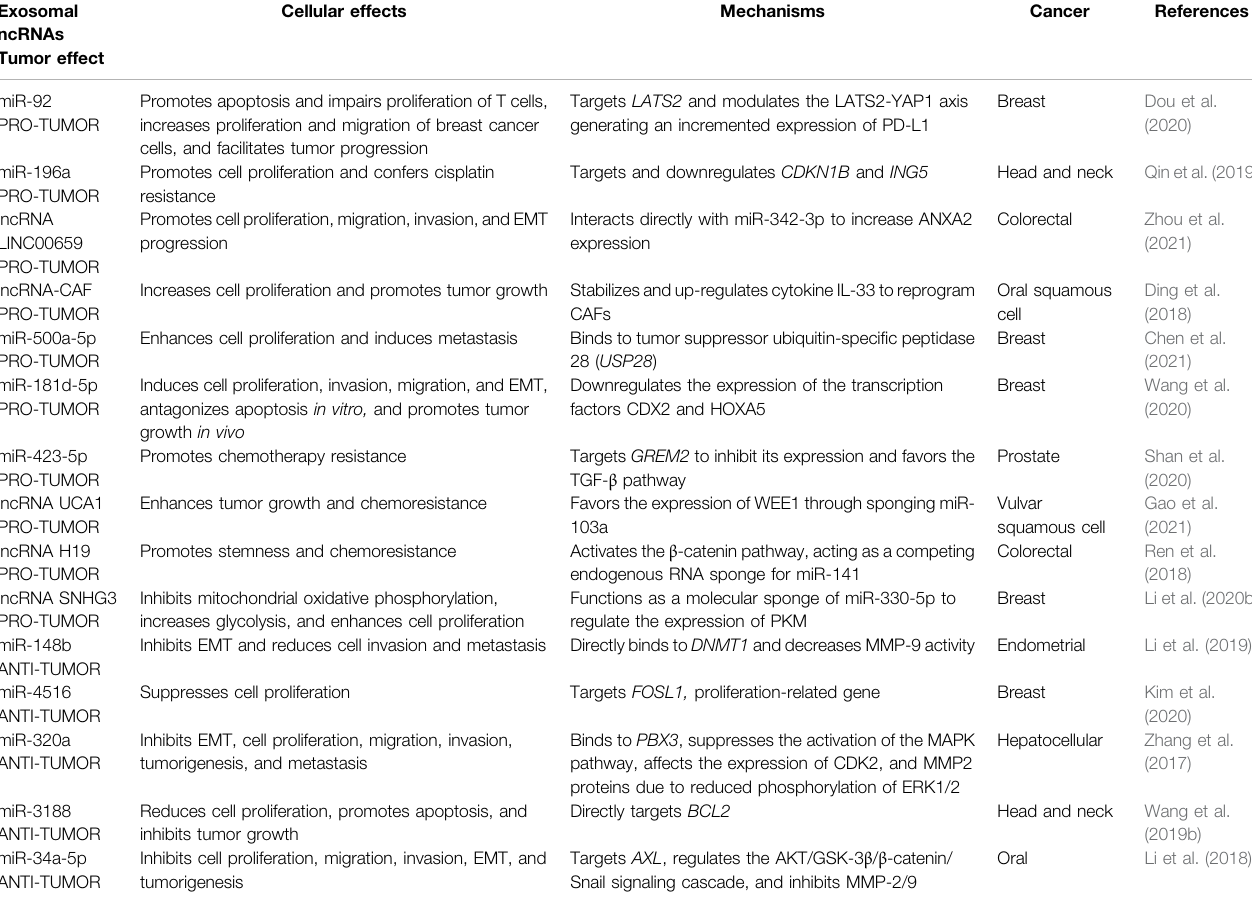
TABLE 1 | Cellular and tumor effects and mechanisms exerted by exosomal miRNAs and lncRNAs derived from CAFs in various cancers. Exosomal